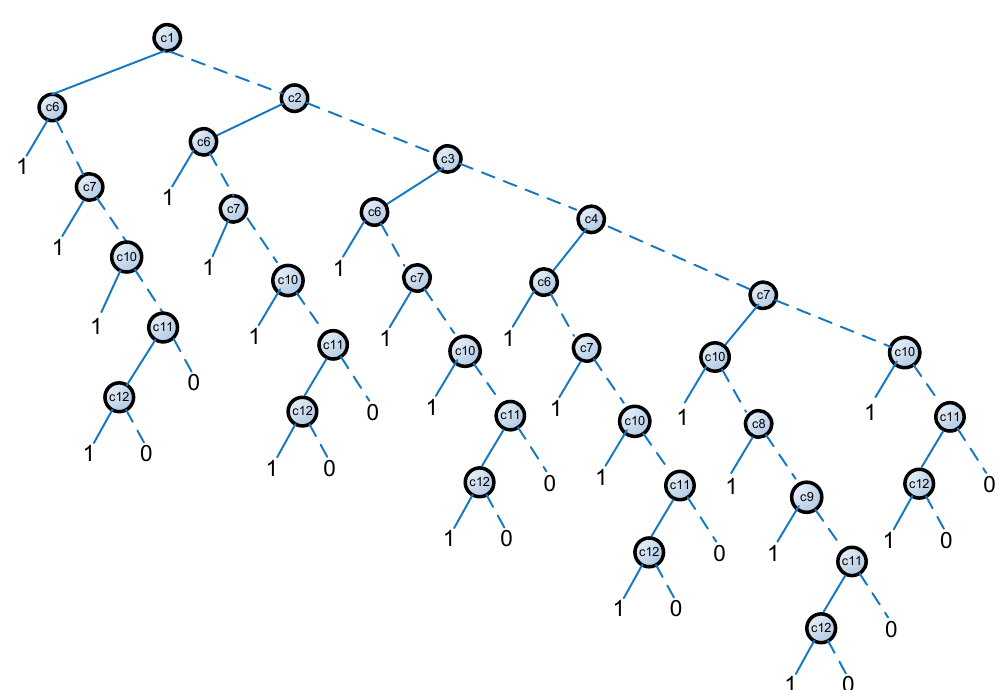
Figure 3. BDD of the FT from Figure 2, obtained by the depth-first-search (DFS) method (see Table 2).